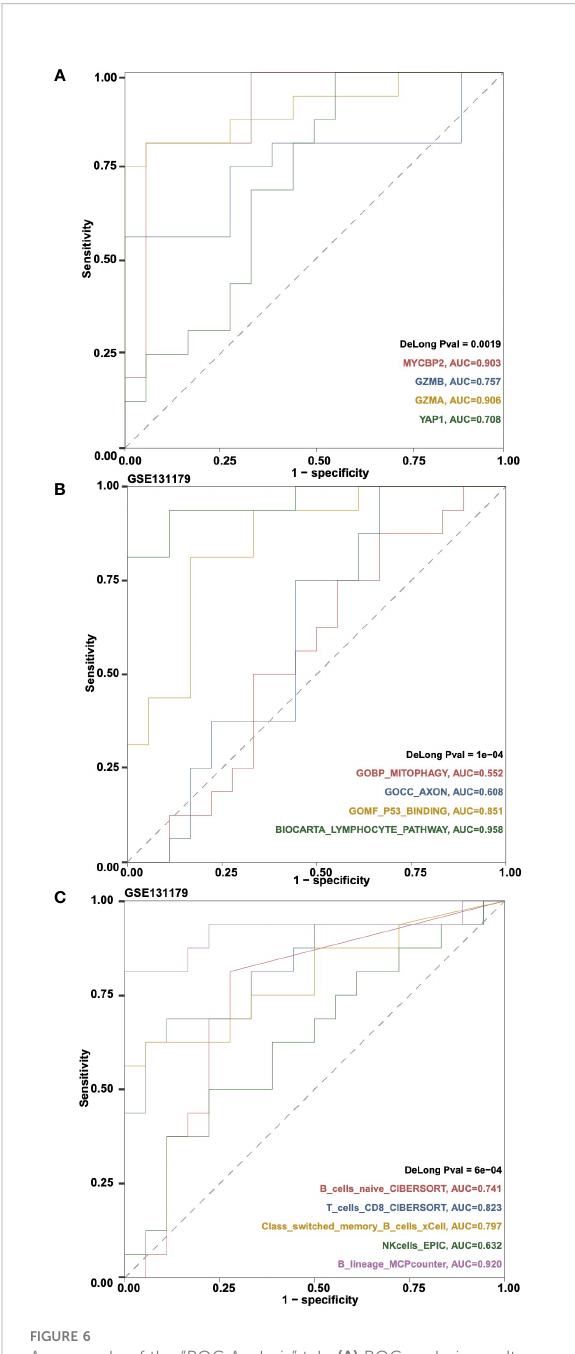
FIGURE 6 An example of the “ ROC Analysis ” tab. (A) ROC analysis results on the gene expressions MYCBP2, GZMB, GZMA and YAP1 in cohortGSE131179. (B) ROC analysis results on the ssGSEA pathways GOBP_MITOPHAGY, GOCC_AXON, GOMF_P53_ BINDING and BIOCARTA_LYMPHOCYTE_PATHWAY in cohort GSE131179. (C) ROC analysis results on the immune cells B_cells_naive_CIBERSORT, T_cells_CD8_CIBERSORT,